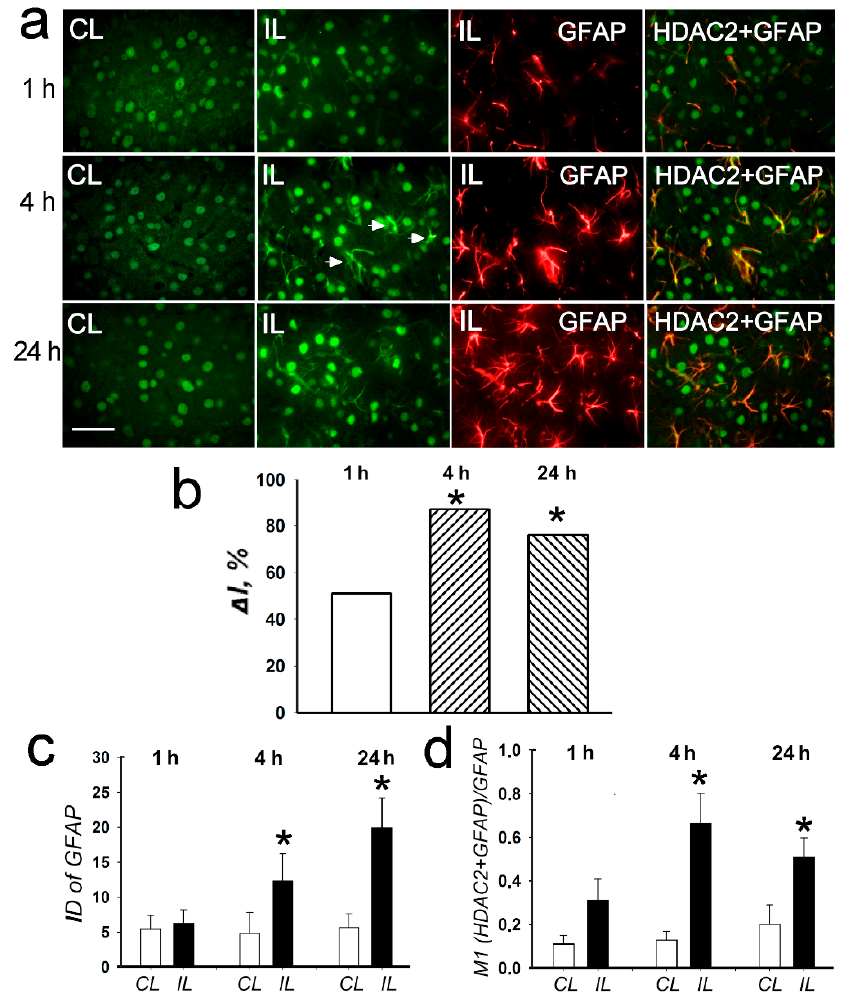
Figure 5. The cellular distribution of histone deacetylase HDAC2 in the penumbra at 1, 4 or 24 h after PTS in the rat cerebral cortex. ( a ) The typical immunofluorescence images of HDAC2 localization (green) in the ischemic penumbra (IL) and in the control contralateral cortex (CL), the expression of astroglia marker GFAP (red) and merged images of HDAC2 and GFAP. HDAC2 fluorescence in GFAP-labeled astrocytes is yellow. White arrows—HDAC2 expression in astrocytes. Scale bar, 20 μ m. ( b ) Percent changes in fluorescence intensity of HDAC2-positive cells in the ischemic penumbra 1, 4 or 24 h after photothrombotic stroke in the rat cerebral cortex relatively to that in the control contralateral cortex. Δ I % is the mean corrected total cell fluorescence (CTCF) averaged over penumbra minus mean control CTCF/ mean control CTCF × 100% (experiment versus control). ( c ) Integrated optical density of GFAP-positive cells (ID—fluorescence intensity per a unit of surface area). ( d ) Manders’ coefficients M1 display PTS-induced changes in co-localization of HDAC2 with GFAP. n = 7. * p < 0.05.